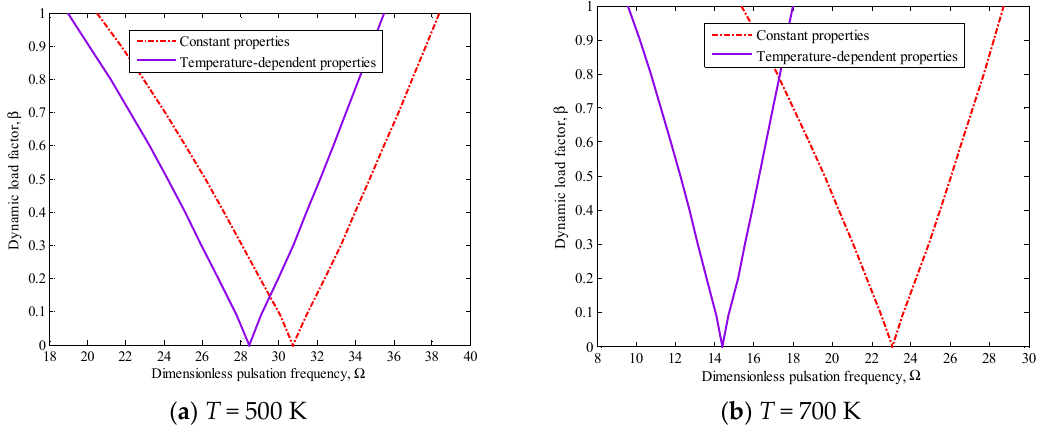
Figure 3. Comparison between the DIR of SLGS resting on the elastomeric foundation for constant and temperature-dependent properties.